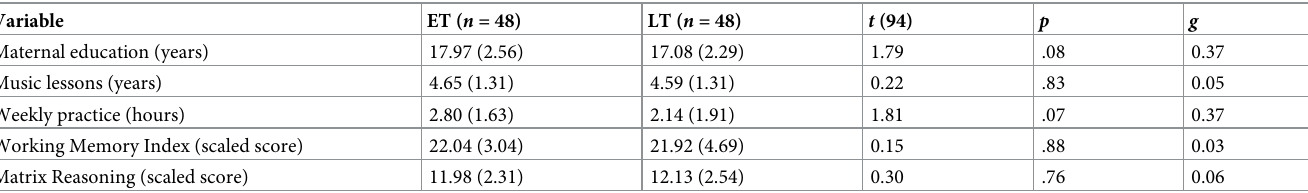
Matrix Reasoning (scaled